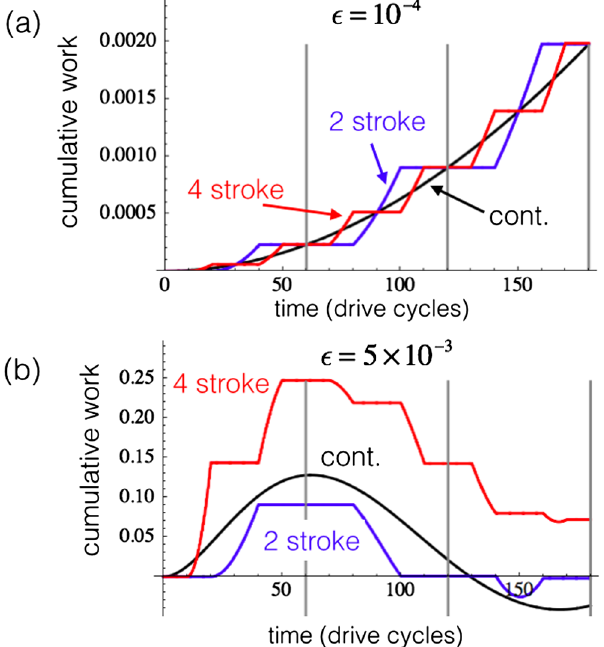
FIG. 6. (a) The equivalence of heat engine types in transient evolution when the engine action is small compared to ℏ . (a) The cumulative power transferred to the work repository is plotted as a function of time. All engines start in the excited state j 4 i , which is very far from the steady state of the system. At complete engine cycles (vertical lines), the power in all engines is the same. (b) Once the action is increased (here, the field ϵ was increased), the equivalence no longer